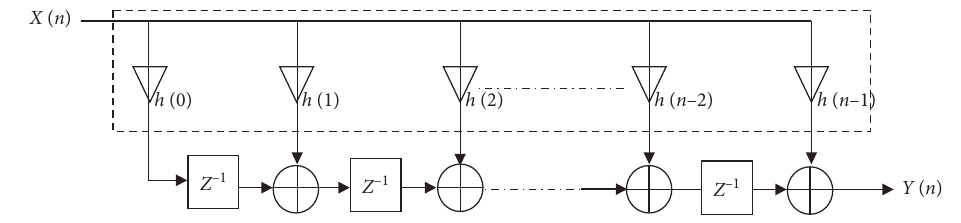
Figure 2: Transposed direct form FIR filter architecture.